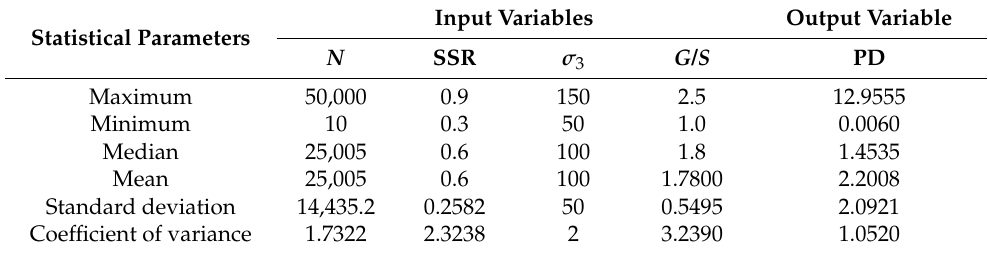
Table 5. Statistical parameters of the input and output variables used in this